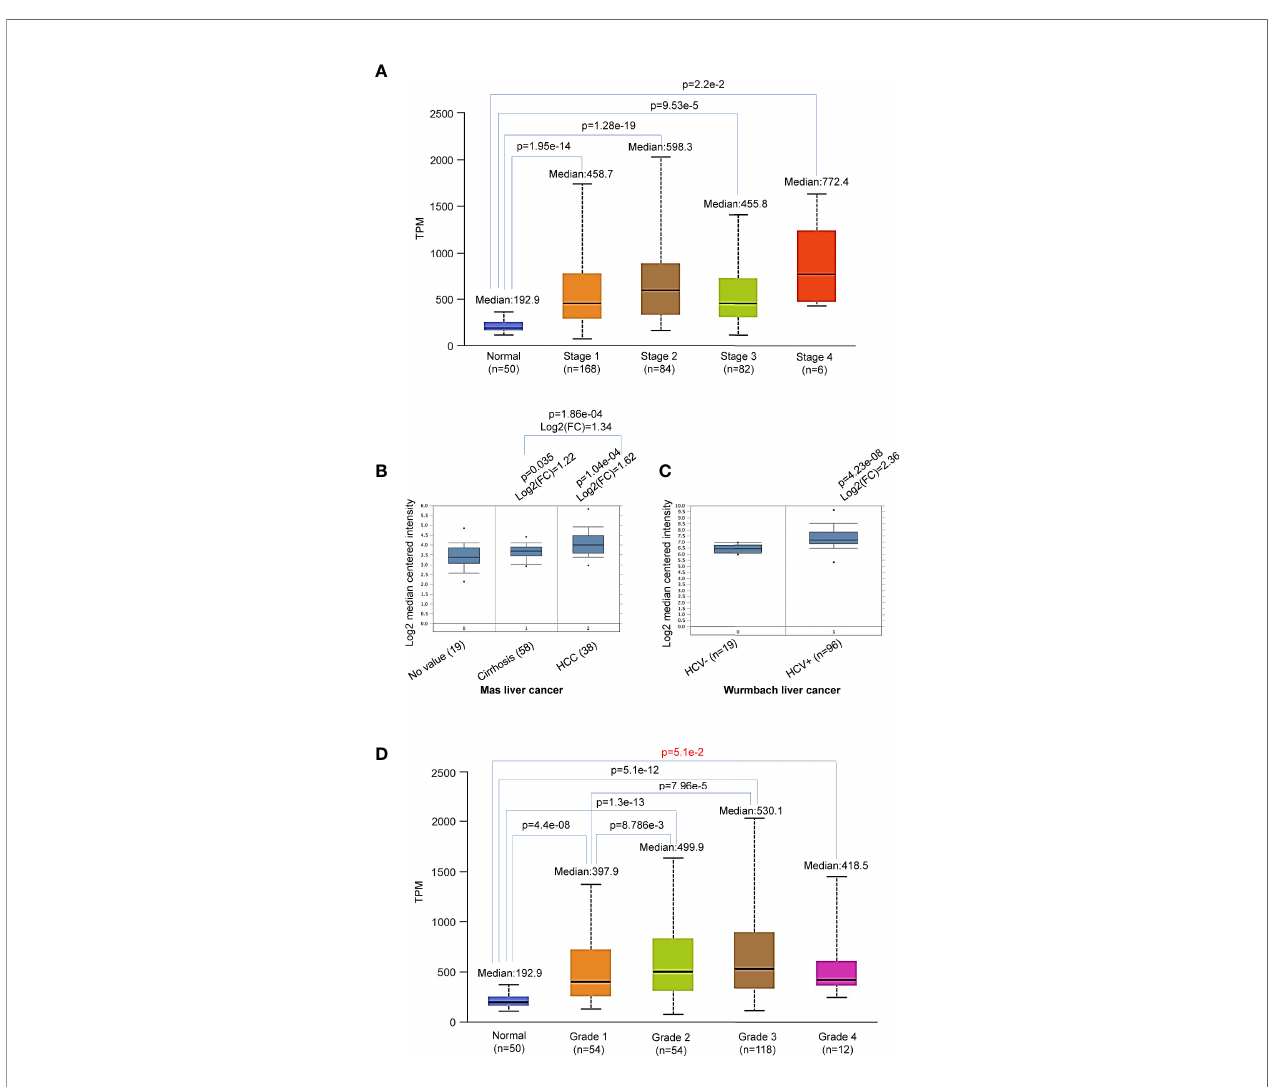
FIGURE 3 | Differential expression of Sqstm1 in liver cancer stages and grades. (A, B) Sqstm1 is upregulated as early as liver cirrhosis and through all stages. (C) HCV infection is signi fi cantly associated with Sqstm1 upregulation. (D) Differential upregulation of Sqstm1 in clinical stages of LIHC. p value in red is not signi fi cant. (A) is the results from UALCAN portal, (B, C) from Oncomine, and (D) from UALCAN. Median Value = median(logData); Median-centered intensity= logData-Median